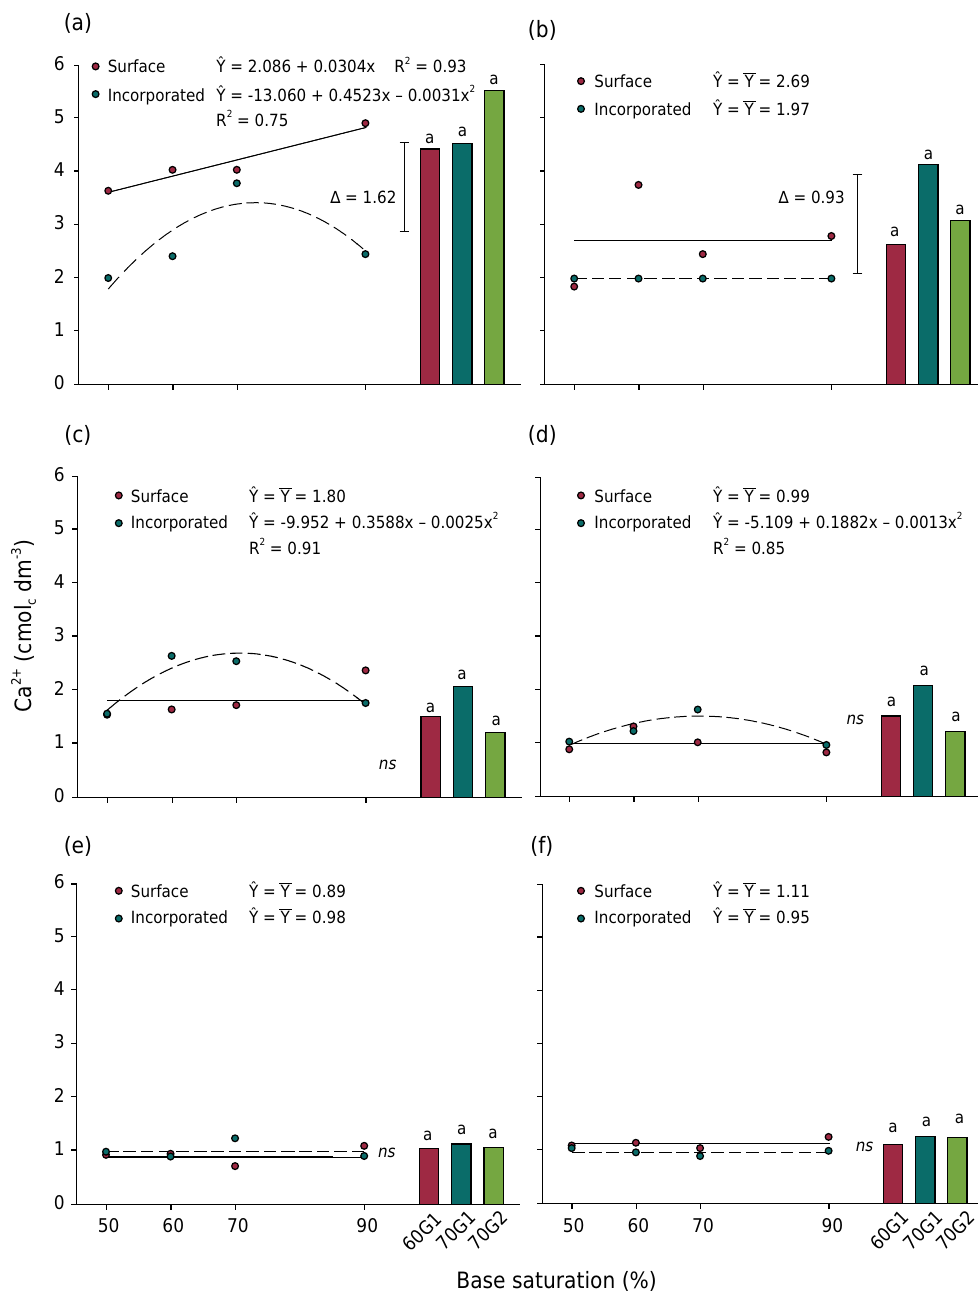
Figure 4. Soil calcium (Ca 2+ ) content in the 0.00-0.05 (a), 0.05-0.10 (b), 0.10-0.20 (c), 0.20-0.30 (d), 0.30-0.40 (e), and 0.40-0.60 m (f) layers 48 months after treatment. Soils were limed to different base saturation (BS) levels (50, 60, 70, and 90 %) by surface application (SL) or lime incorporation (IL) or treated by surface application of lime (60 and 70 % BS) and a standard (G1) or double (G2) dose of phosphogypsum as 60G1, 70G1, and 70G2. Different letters above columns indicate significant differences between phosphogypsum treatments (Tukey’s test, p<0.05). Vertical bars represent least significant differences between treatments (Dunnett’s test,